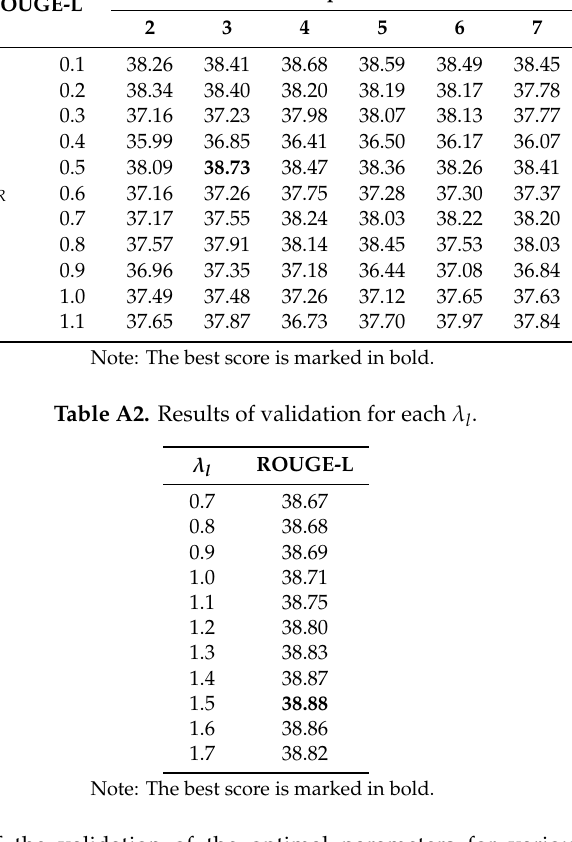
Table A3. Results of the validation of the optimal parameters for various combinations of proposed